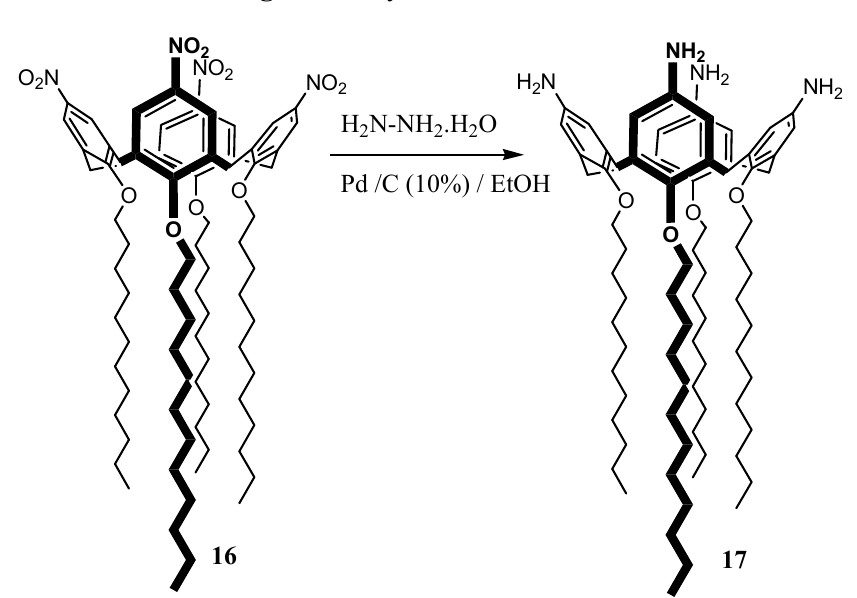
Figure 23. Synthetic route to 17